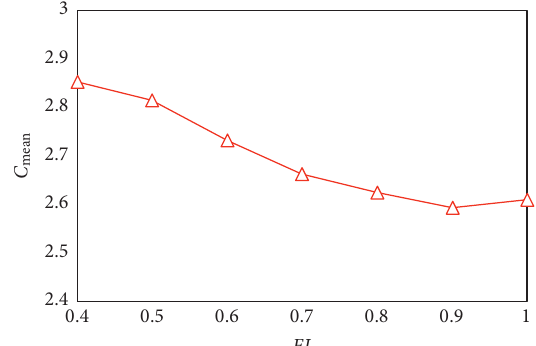
Figure 15: Change curve of the mean coordination number with respect to elongation.